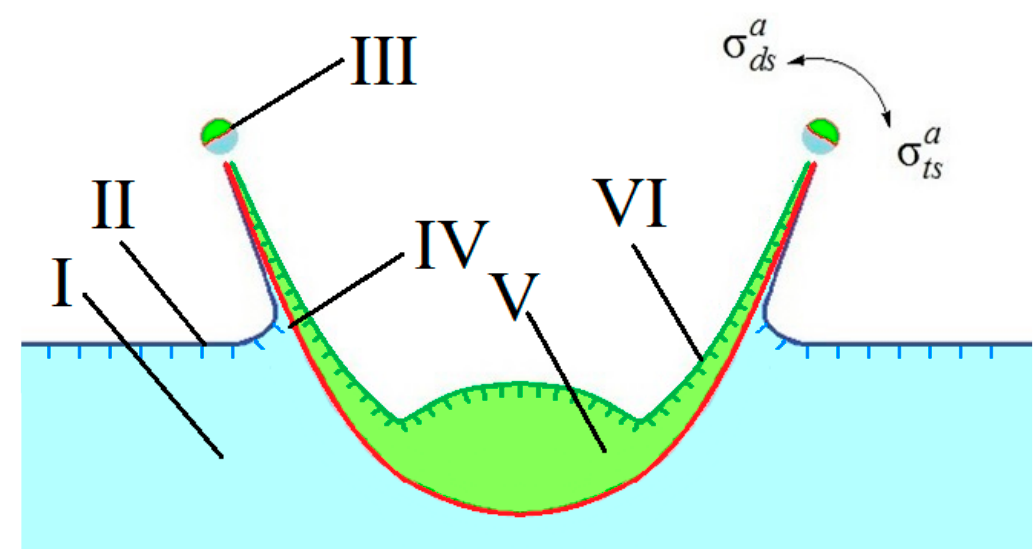
Figure 19. Cross-section scheme of the flow in the impact mode: I is the target fluid, II is the surface of the target fluid, III is the ejected droplet containing both merging fluids, IV is the double energy loaded layer is the contact area of the boundaries of the merging fluids, V is the droplet material, VI is the free surface of drop material.